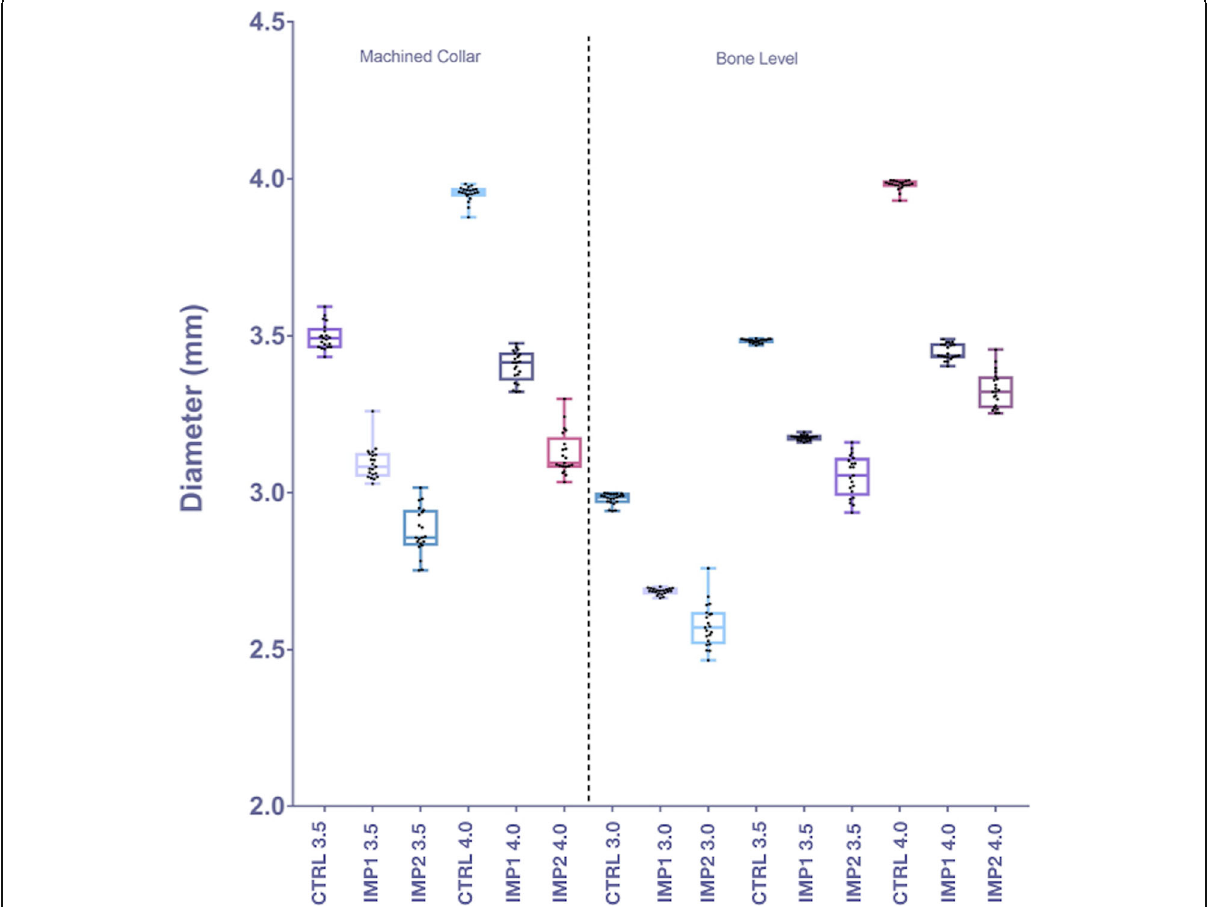
Fig. 7 Boxplot graphs showing the data for the IMP1 and IMP2 groups with machined collar and bone-level implants after implantoplasty and the control groups according to